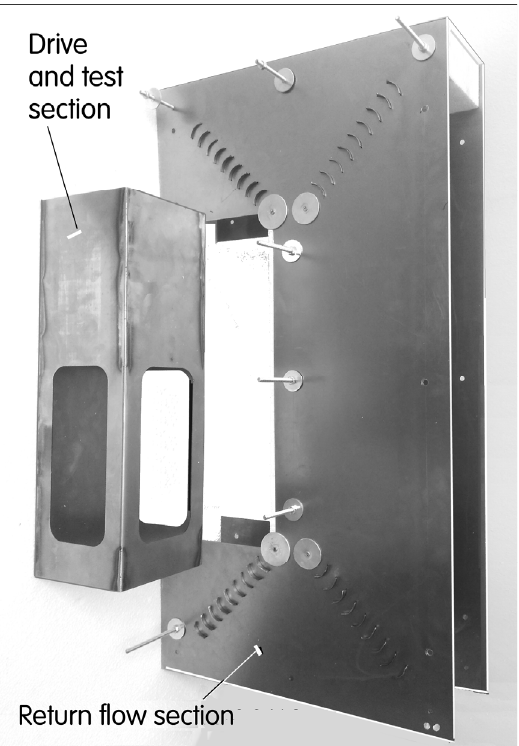
Fig. 22. Photograph of the two main components of the wind tunnel in construction. Both are made of steel sheets as the shape-carrying structure – at left is the test section with the large rectangular windows, at right is the flow-return part. The latter will be covered with thermal insulation cladding of thermal insulation thick polystyrene foam plates.